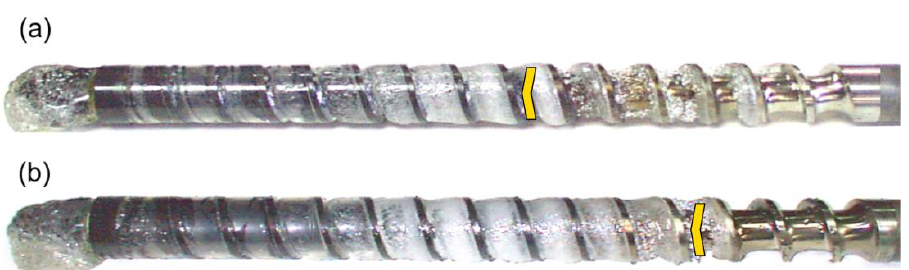
Figure 6. An effect of the screw speed on the polymer flow in the injection molding process at the plastication stroke h plast = 1 D, and the back pressure P back = 0 MPa: ( a ) N = 100 rpm, ( b ) N = 300 rpm.